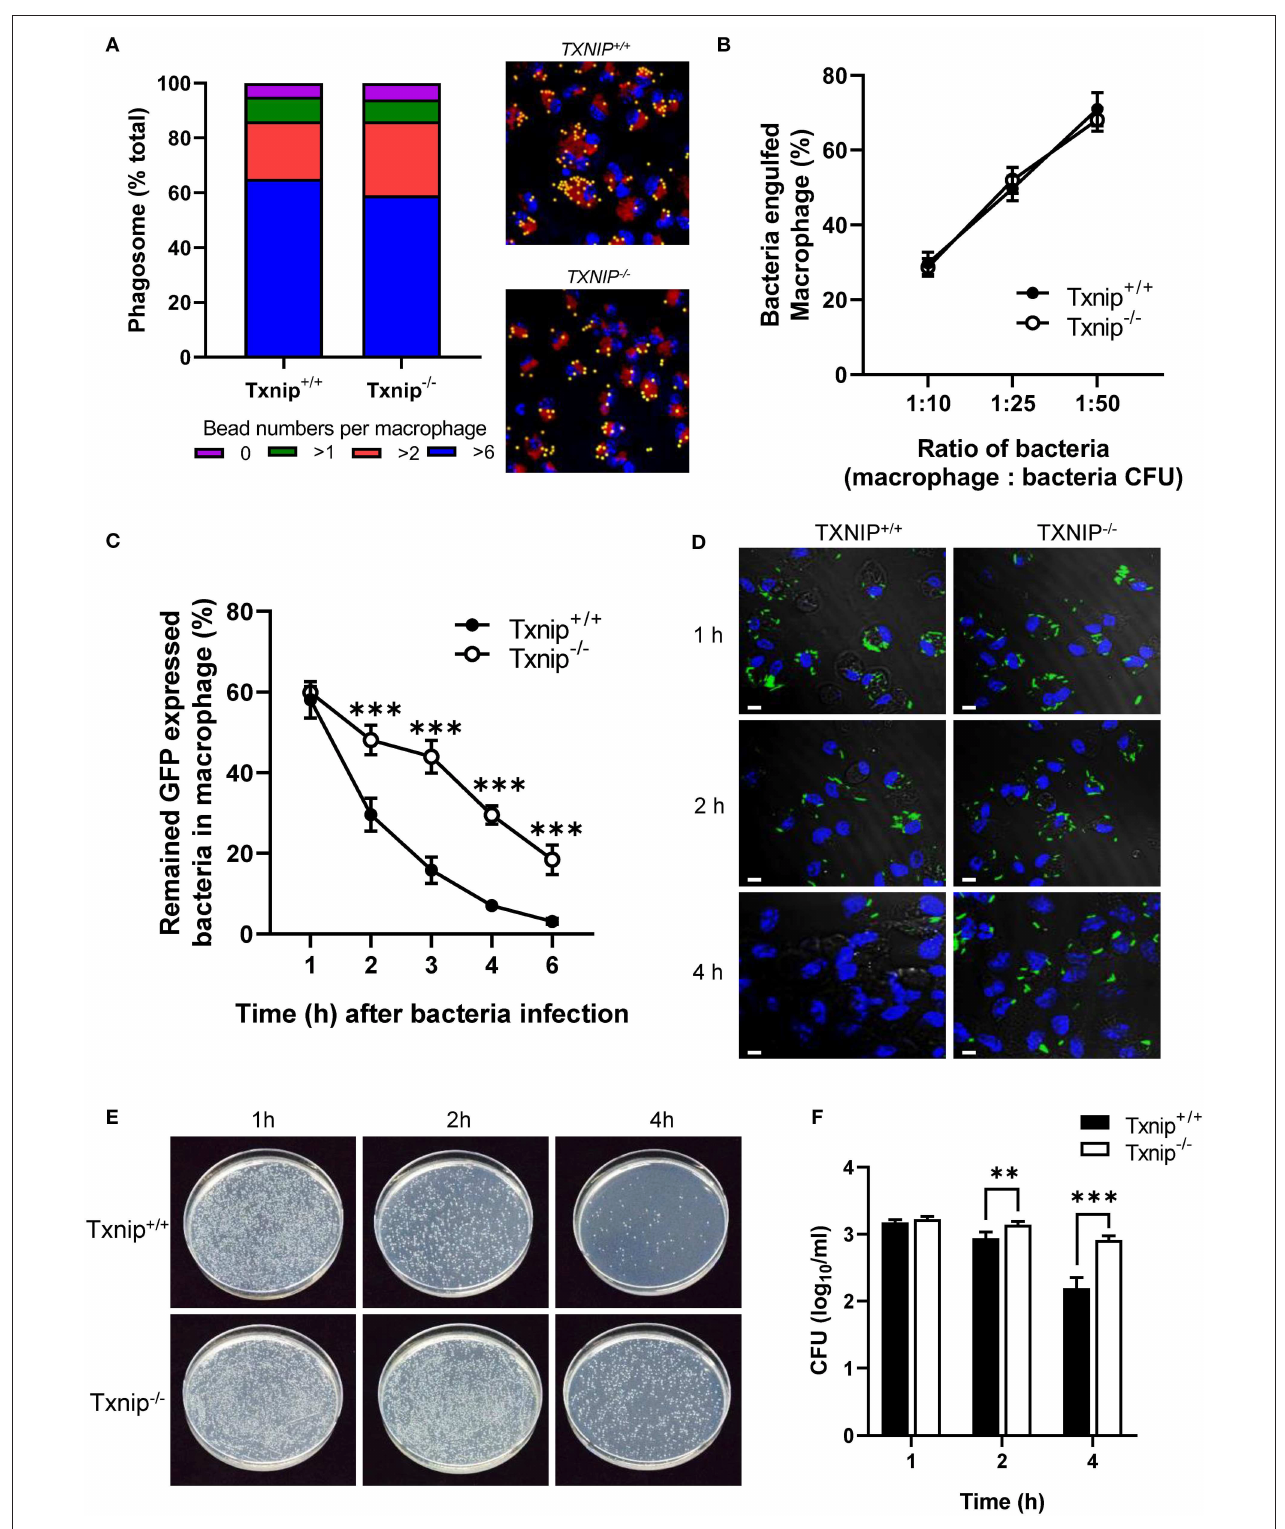
FIGURE 1 | Thioredoxin-interacting protein (TXNIP) regulates the clearance of bacteria from macrophages. (A) (Left) The proportion of yellow-green fluorescent FluoSpheres bead numbers in wild-type (WT) and Txnip knockout (KO) mouse peritoneal macrophages. (Right) Representative images showing 2- µ m microbeads in WT and Txnip KO macrophages at 1h after incubation with microbeads (Lamp1, red; DAPI, blue). (B) The proportion of WT and Txnip KO peritoneal macrophages